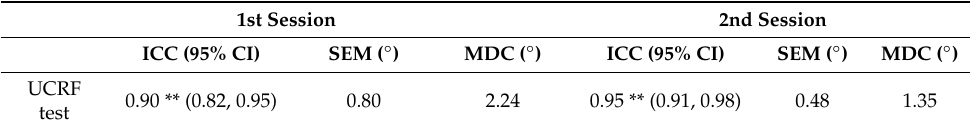
Table 3. Inter-rater reliability for the upper cervical rotation-flexion